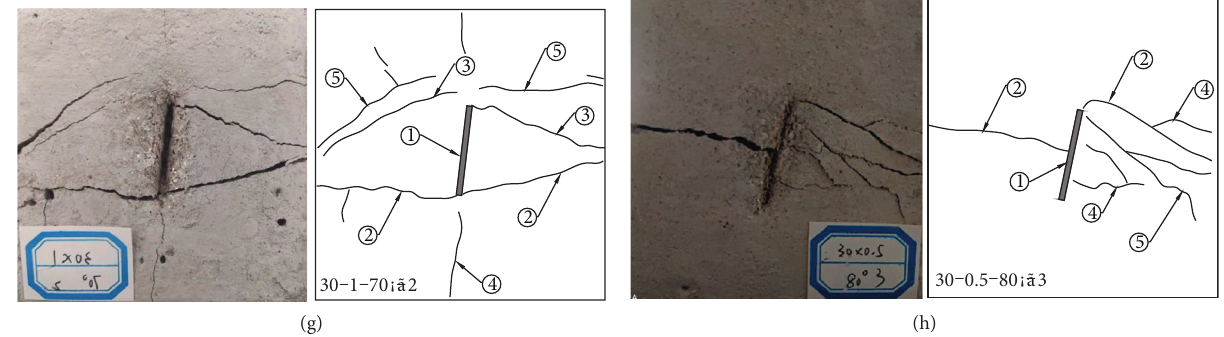
Figure 8: Test results on the dip angle of the prefabricated fissure and crack coalescence mode. Note: ① prefabricated fissure; ② shear crack; ③ secondary shear crack; ④ secondary tensile crack; ⑤ secondary tensile-shear crack.